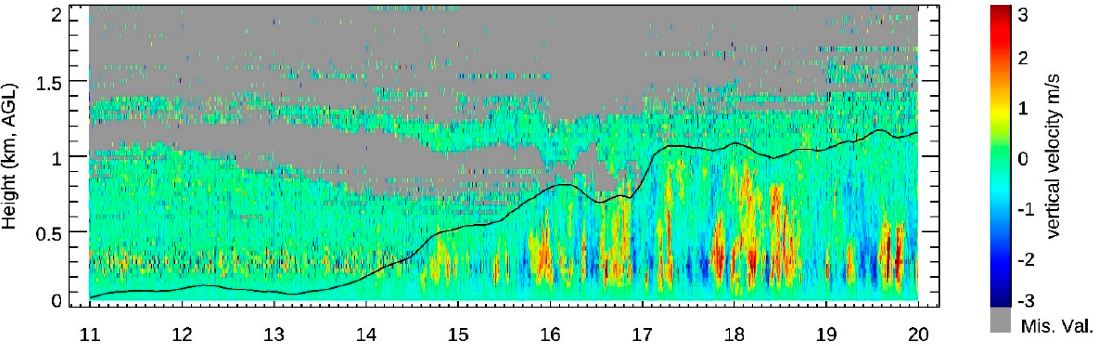
Figure 7. Vertical wind velocity measured by CWAL. The positive and negative values represent upward and downward motion, respectively. The solid black line indicates the PBL heights obtained based on the backscatter profile of CWAL.